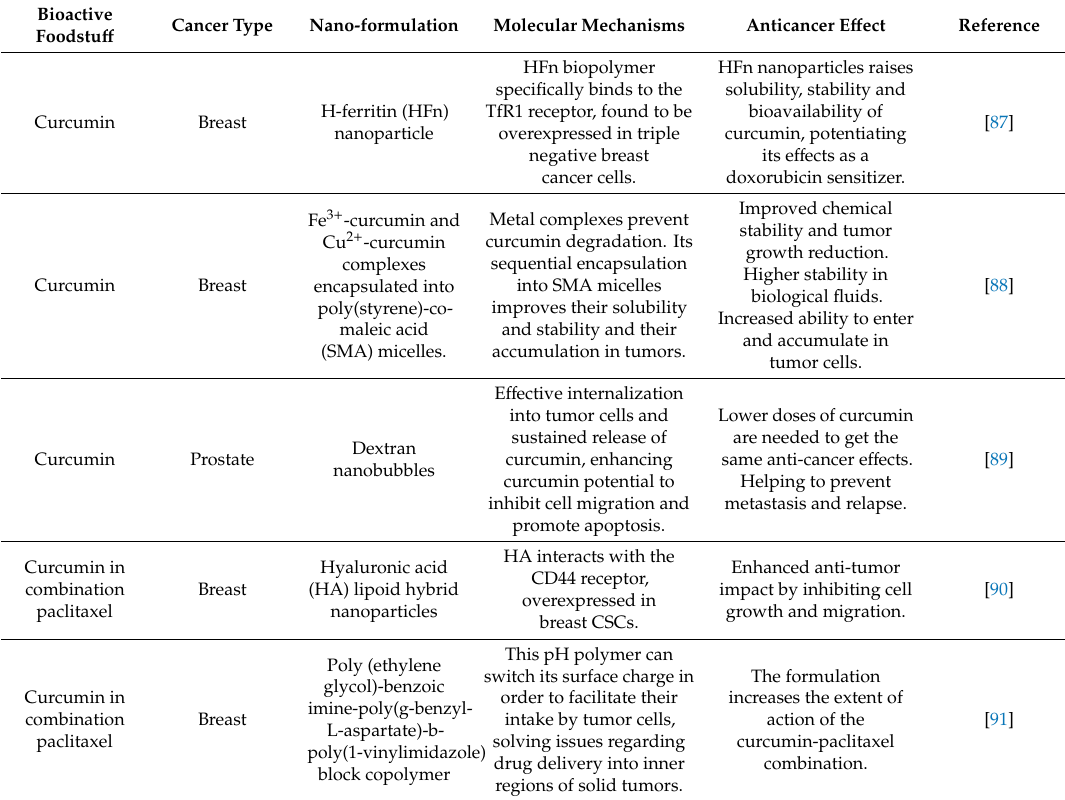
Table 4. Curcumin